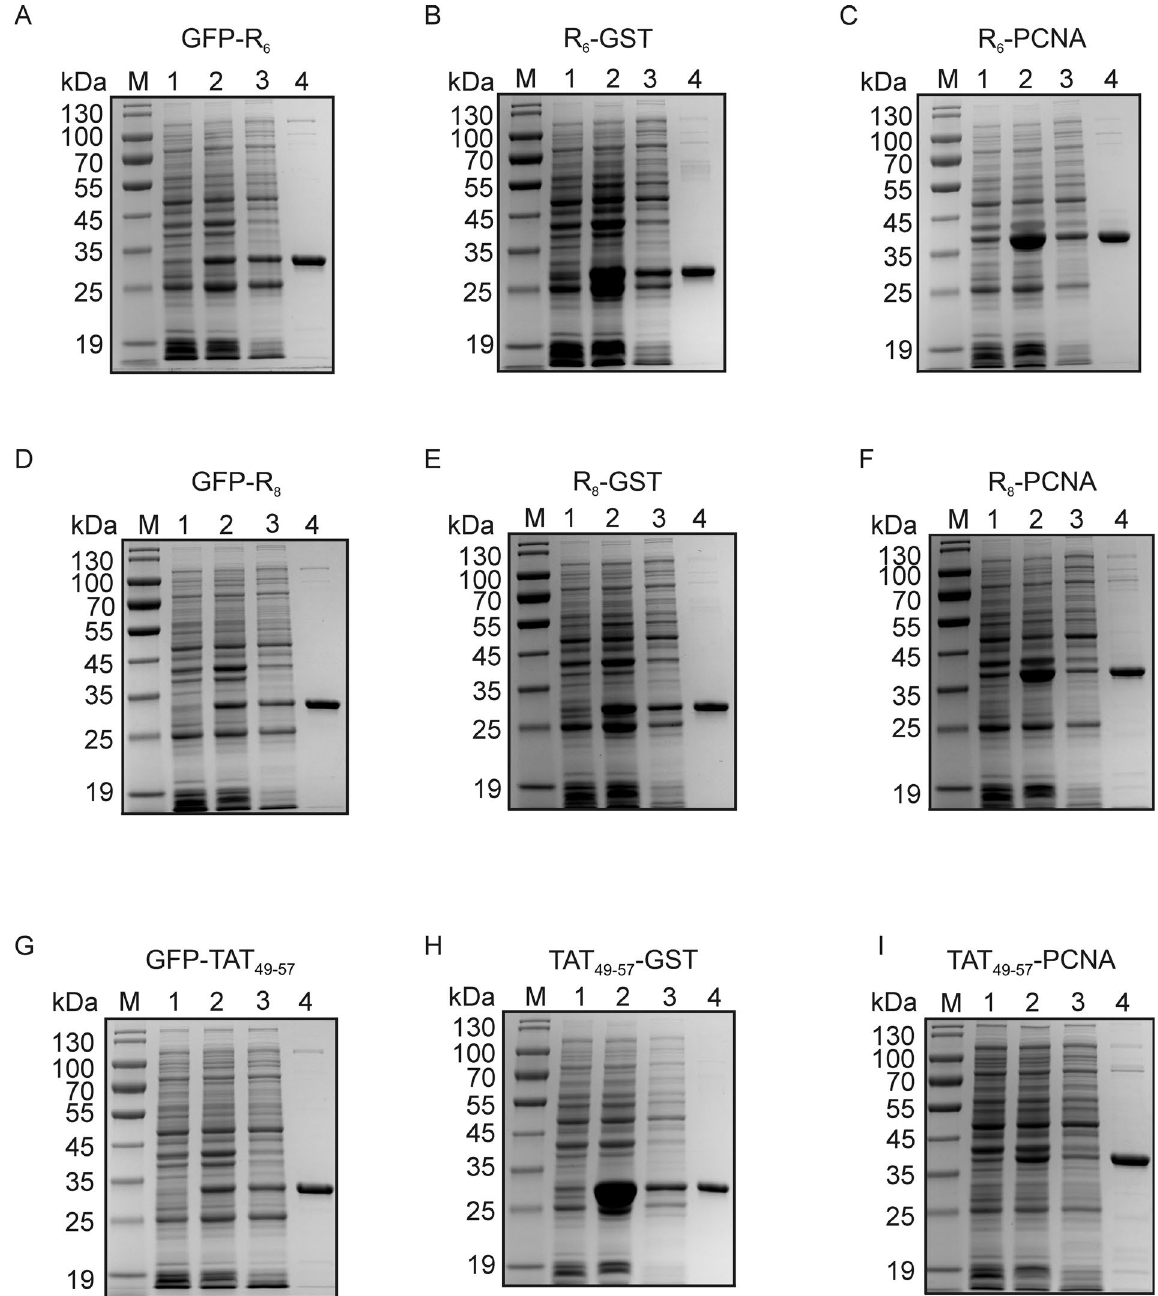
Figure 9. Analysis of arginine-rich peptide-tagged protein purification from E. coli total protein extract using AR aptamer-based chromatography. The recombinant proteins: GFP-R 6 ( A ), R 6 -GST ( B ), R 6 -PCNA ( C ), GFP-R 8 ( D ), R 8 -GST ( E ), R 8 -PCNA ( F ), GFP-Tat 49–57 ( G ), Tat 49–57 -GST ( H ) and Tat 49–57 -PCNA ( I ) were overexpressed and purified from E. coli total protein extract using AR aptamer. Lanes: M) molecular weight marker; 1) non- induced BL21-CodonPlus(DE3)-RIL[pET29a arginine-rich peptide-tagged protein] cells; 2) induced BL21- CodonPlus(DE3)-RIL [pET29a arginine-rich peptide-tagged protein] cells; 3) cell lysate; 4) 4 μ g of protein sample eluted from AR aptamer-based resin using ARGI buffer supplemented with GuHCl. The samples were denatured and separated on 12% SDS-PAGE followed by Coomassie brilliant blue staining. This is one of three independent experiments which is